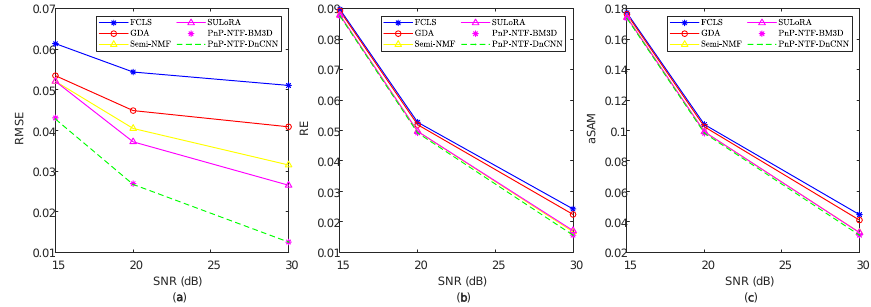
Figure 3. Unmixing performance in terms of root-mean-square error (RMSE) ( a ), reconstruction error (RE) ( b ), and average of spectral angle mapper (aSAM) ( c ) in the simulated ‘Scene1’ with different Gaussian Noise Levels. Table 2. Evaluation Results in ‘Scene2’ with different SNRs and time cost (s).